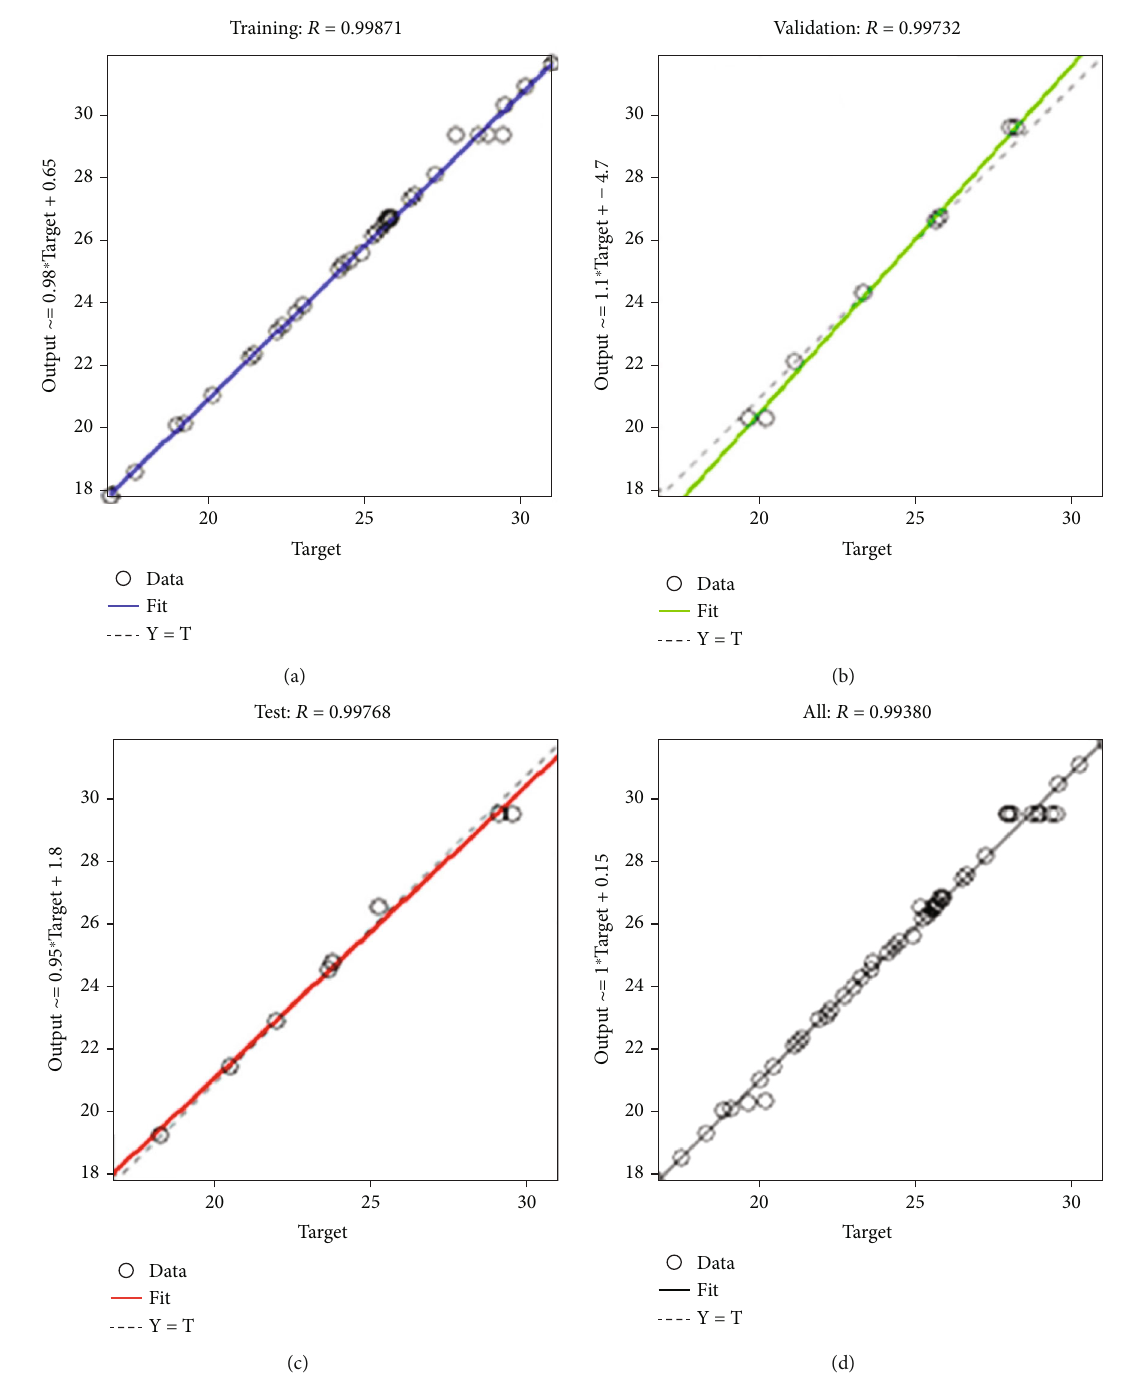
Figure 2: (a) Training data, (b) validation data, (c) test data, and (d) relation between predicted and experimental data set of the optimal ANN model.